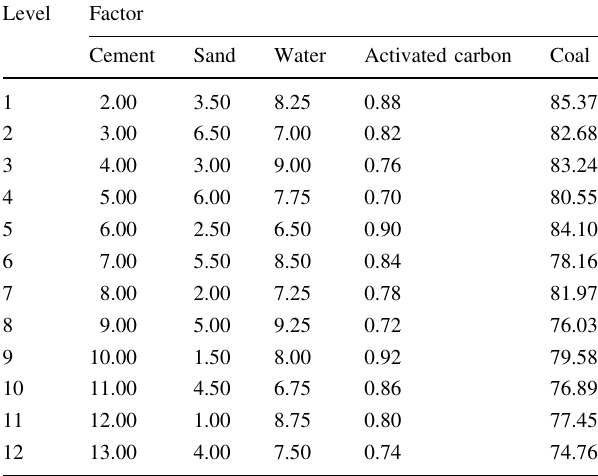
Table 3 Coal-like material experimental design (mass ratio